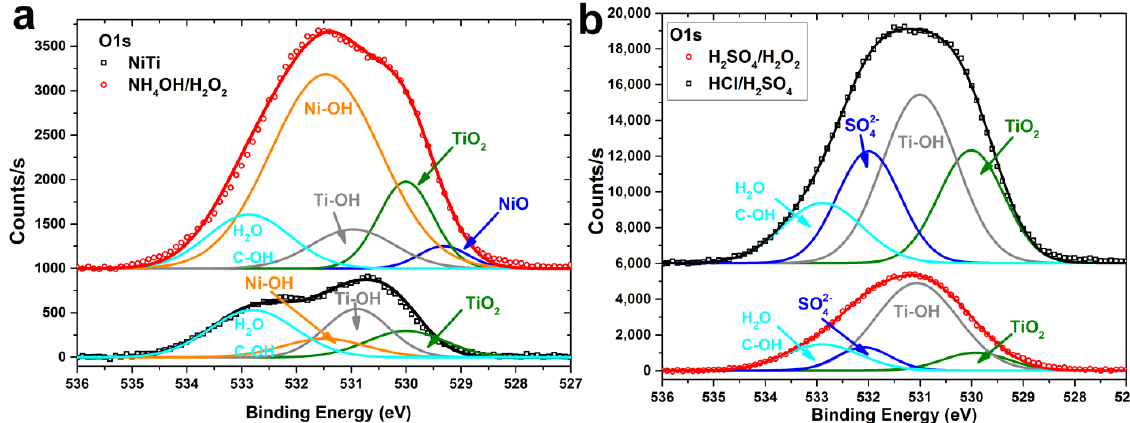
Figure 9. High-resolution O1s XPS spectra of polished NiTi and etched in NH 4 OH/H 2 O 2 -120 min samples ( a ) and etched in HCl/H 2 SO 4 -120 min and H 2 SO 4 /H 2 O 2 -120 min ( b ).